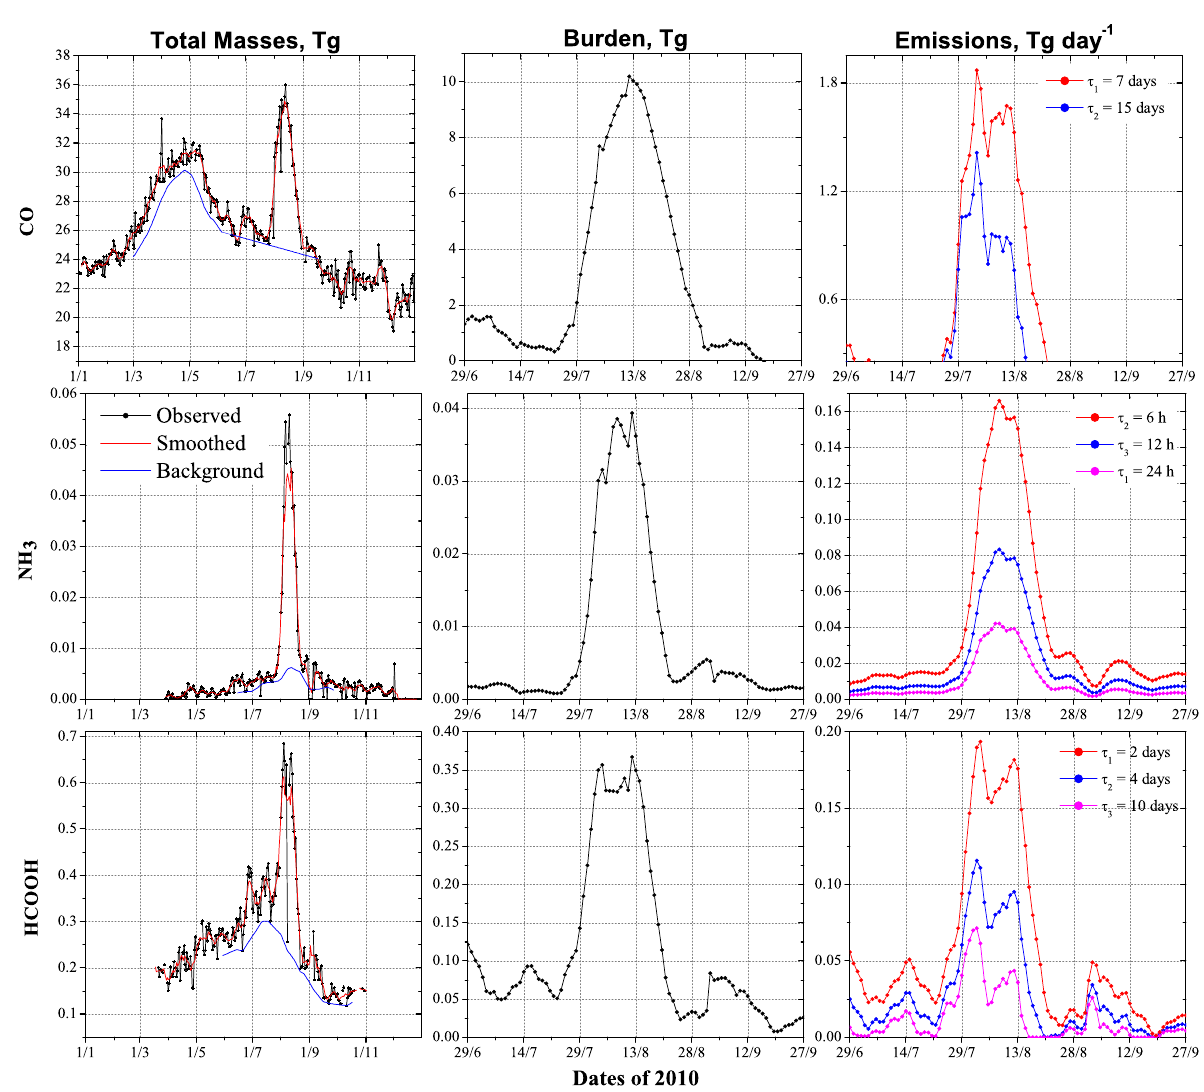
Fig. 4. Left: total CO , NH 3 and HCOOH masses in Tg (black dots and line) over the area 40 ◦ -75 ◦ N, 30 ◦ -150 ◦ E for CO and HCOOH and 40 ◦ -75 ◦ N, 30 ◦ -90 ◦ E for NH 3 . The red lines are the smoothed total masses in 10-day intervals; the blue lines are total masses representative of background concentrations. Middle: extra CO , NH 3 and HCOOH smoothed burden in Tg from fires obtained by subtracting background values from the total masses. Right: Fluxes in Tg day − 1 respectively of NH 3 and HCOOH calculated by equation 3.